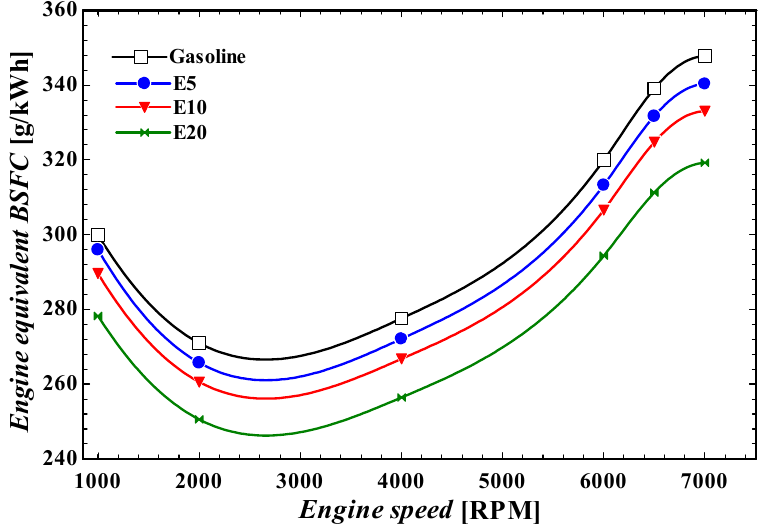
Figure 4. Engine equivalent BSFC at various engine speeds at different fractions of ethanol.